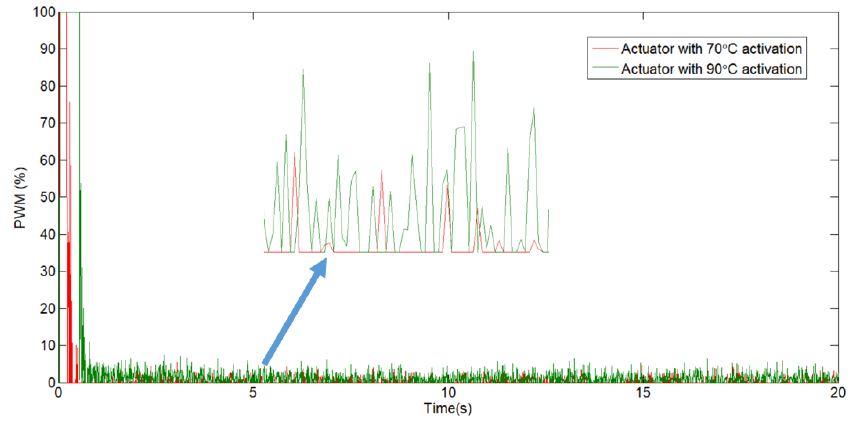
Figure 6. Actuator PWM signals with activation in 90 ◦ C respectively 70 ◦